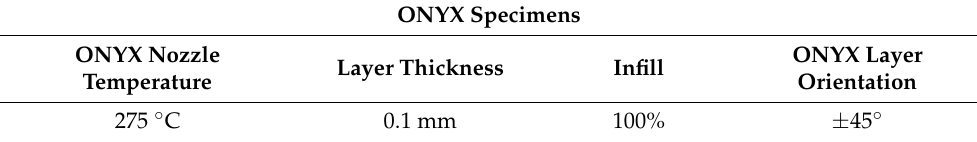
Table 2. ONYX Specimen printing parameters.